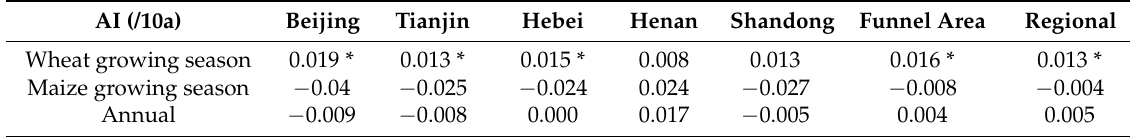
Figure 11. The spatial distribution and statistical significance of the trends in the aridity index on ( a ) the winter-wheat growing season; ( b ) the summer-maize growing season and ( c ) the annual basis. Table 10. Province-wide, funnel area and regional statistics for wheat, maize, and annual average aridity index